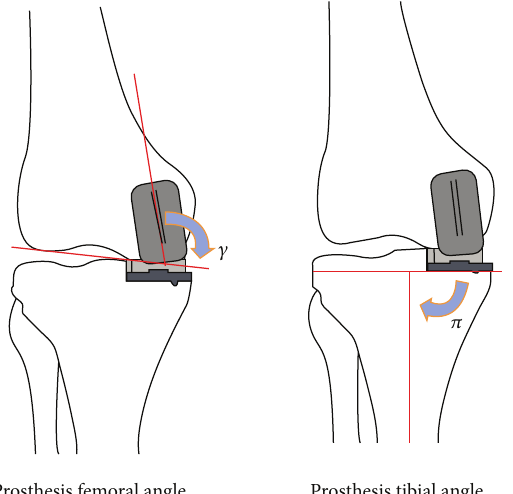
Figure 2: Prosthesis-femoral angle ( 𝛾 ) in the coronal plane formed by the intersection of the long axis of femoral prosthesis and the axis perpendicular to a line that passes by the distal femoral condyles and prosthesis-tibial angle ( 𝜋 ) in the coronal plane formed by the intersection of the anatomical tibial axis and the line perpendicular to the tibial component